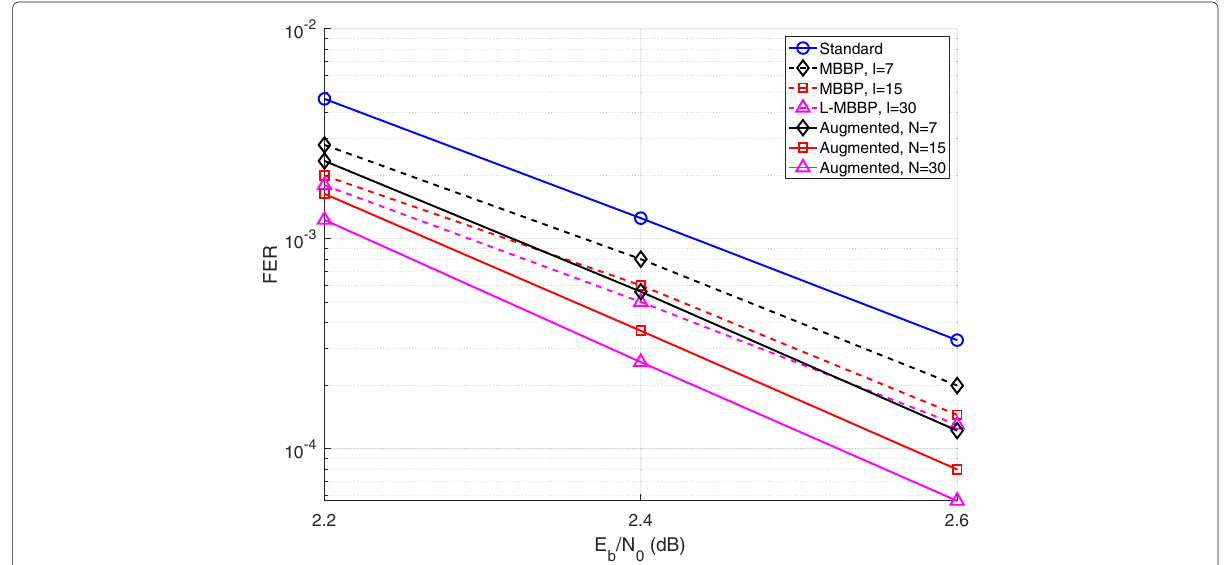
Fig. 7 n = 576 WiMAX FER plot. FER performance of augmented decoders for the n = 576 and R = 1 / 2 WiMAX code. Also shown is the performance of various MBBP